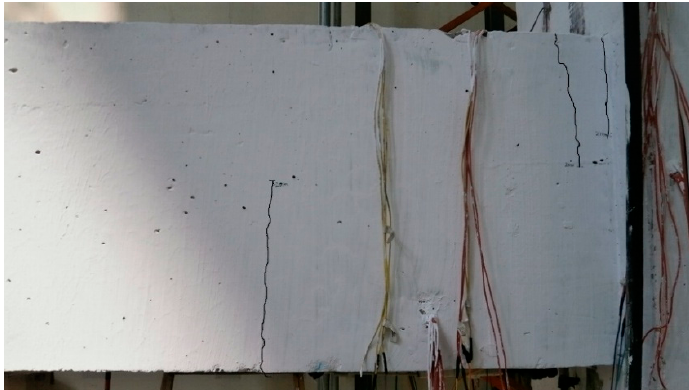
Figure 10. The initial cracking of the first precast prestressed concrete joint (PPCJ1).